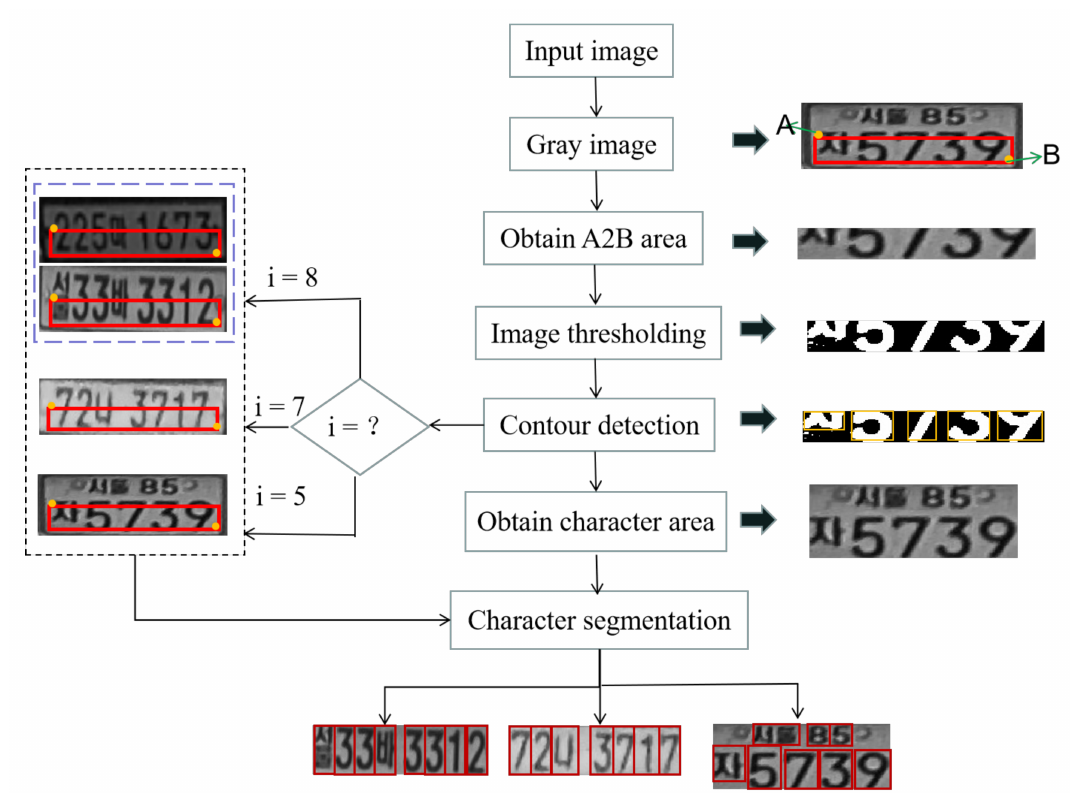
Figure 4. The whole process of character segmentation. ‘i’ means the number of contours. A rectangular area (A2B), which contains a top-left point of A and a bottom-right point B, is obtained to distinguish different types of LPs by